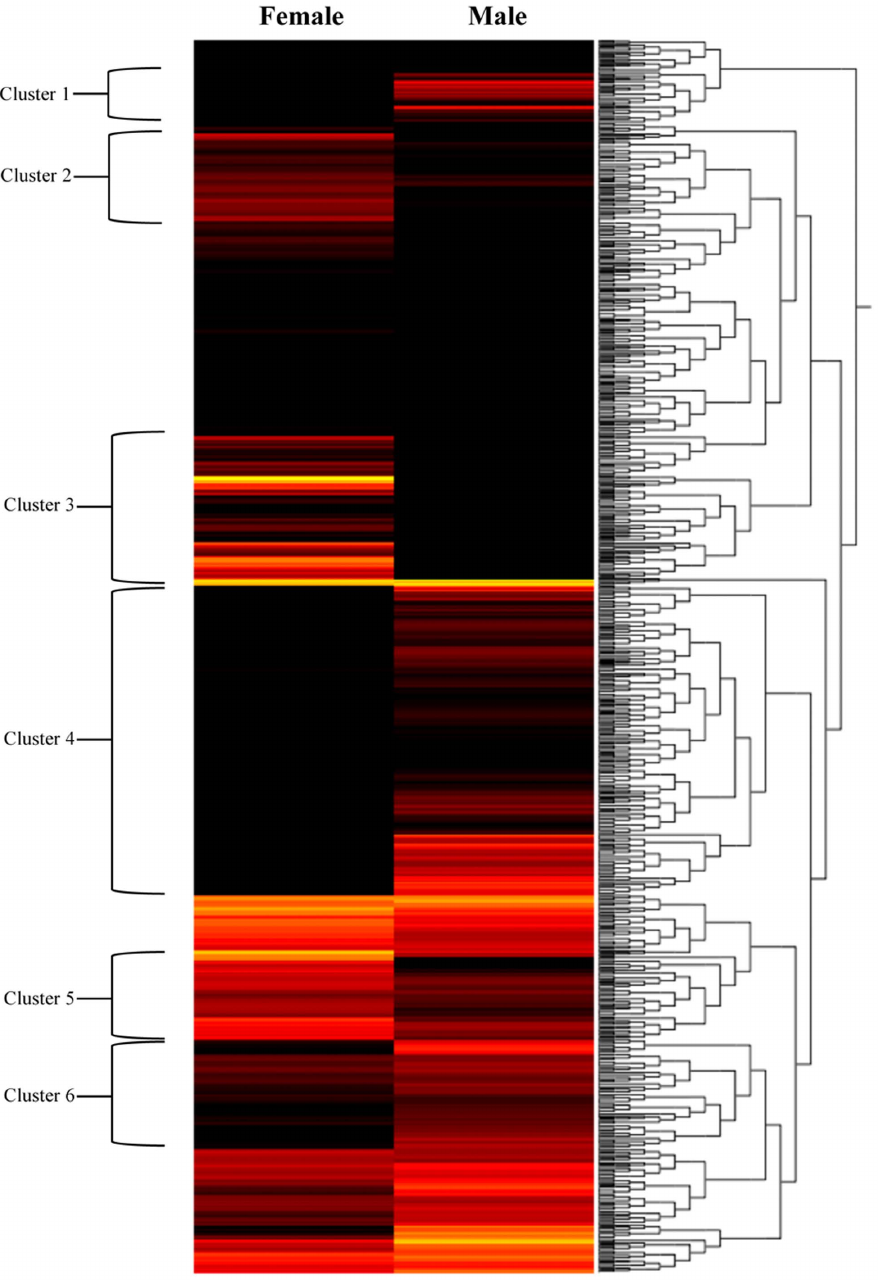
Figure 6. Clusters of gene expression levels between adult females and males of C.rogercresseyi . Dendrograms of the transcription patterns were estimated for 83,444 contigs generated by de novo assembling. The bar color reflects the gene expression level from black (low), red (medium) to yellow (high). Contig annotations of these 6 clusters are listed in Table S4.